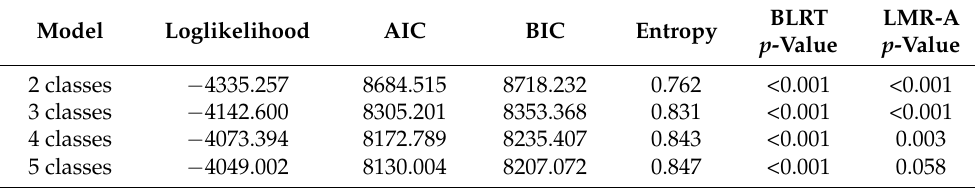
Table 3. Model fit indices of the latent class analyses.